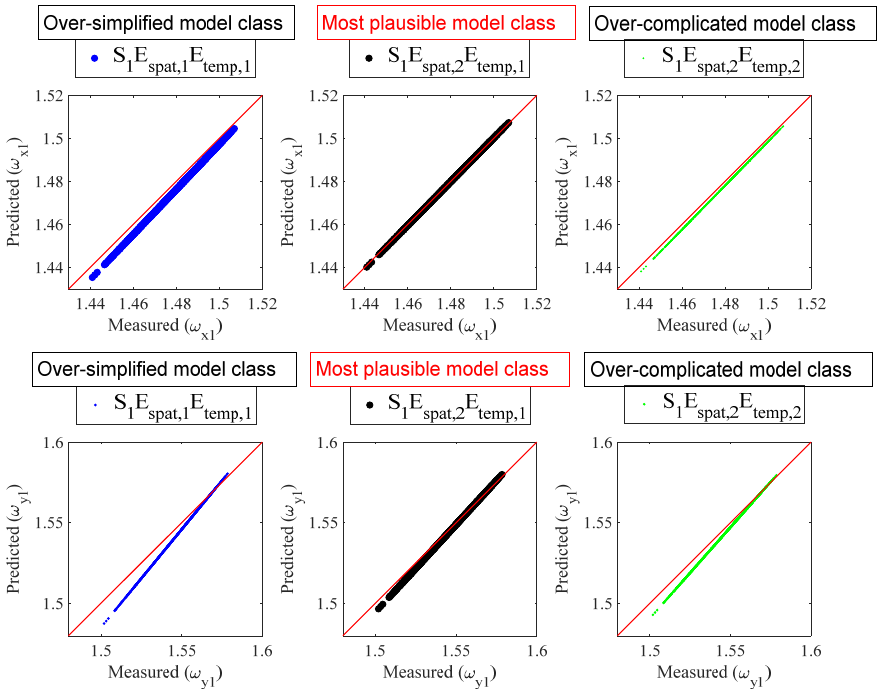
Figure 7. Measured and predicted values of ω x 1 and ω y 1 by different candidate model classes.